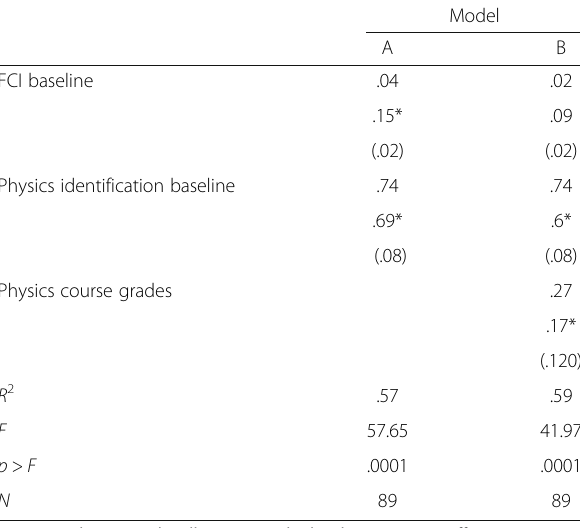
Table 5 Regression models for physics course grades on physics identification